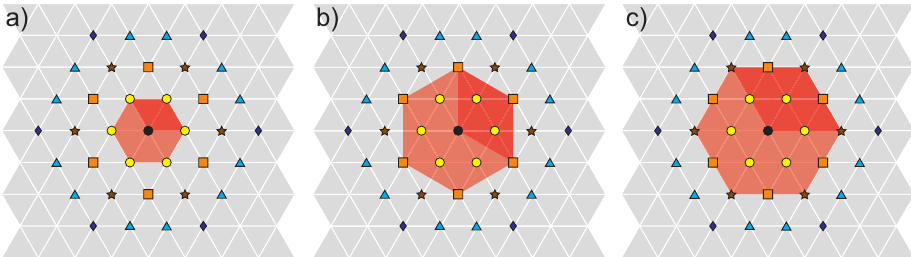
Figure 5. Triangle Wigner 2D lattice of repulsing electrons on a positive jellium at T = 0 K with hexagonal Bravais elementary cell and indicated nearest neighbors ( a ) and two types of next-nearest ones ( b , c ). The hexagonal structure of sublattices of next-nearest neighbors is conserved.